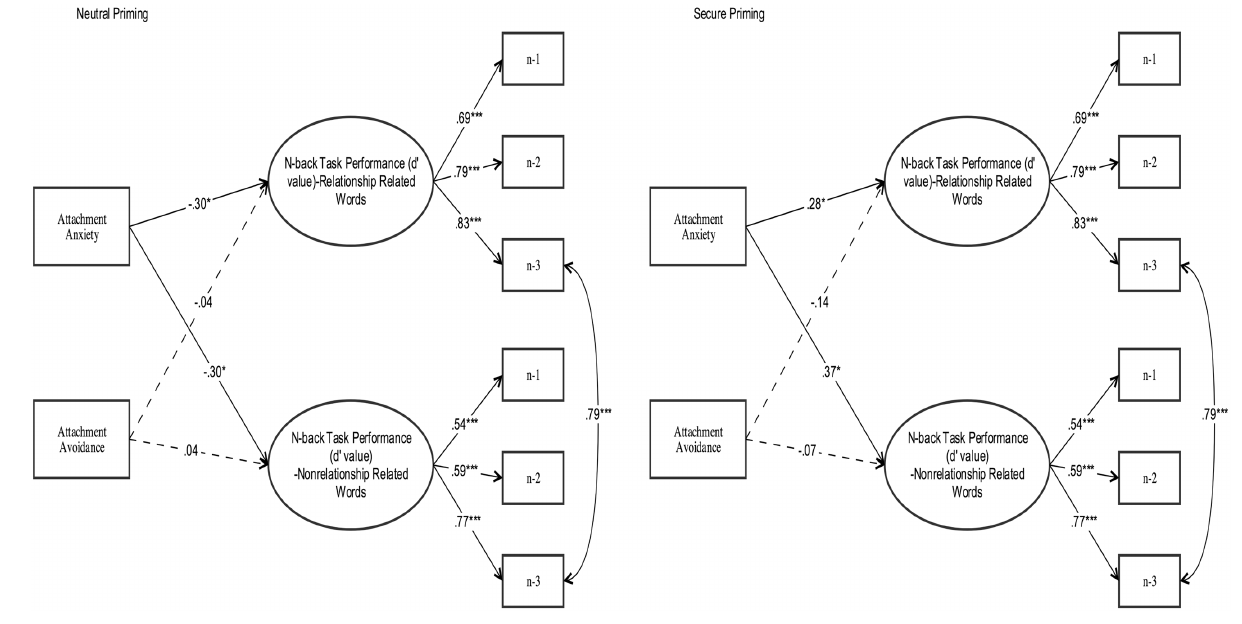
Fig 4. Attachment dimensions predicting the WM